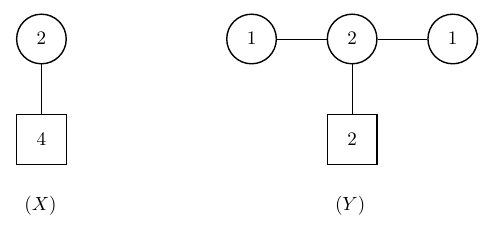
Figure 10 . An example of a pair of linear quivers with unitary gauge groups which are 3d mirrors.